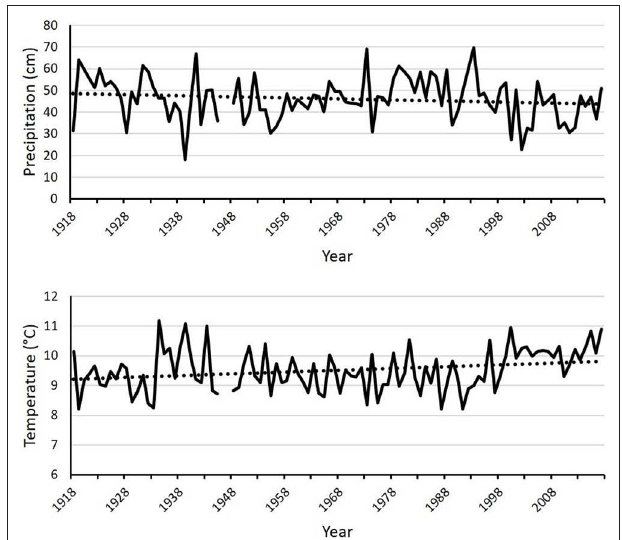
FIGURE 2 | Mean annual precipitation (Top) and temperature (Bottom) from the master climate dataset assembled from three climate stations close to the study sites. Missing values occur where no data were available from any station. Dotted lines are central trendlines. Data are shown by water year (October 1 to September 30), rather than calendar year.